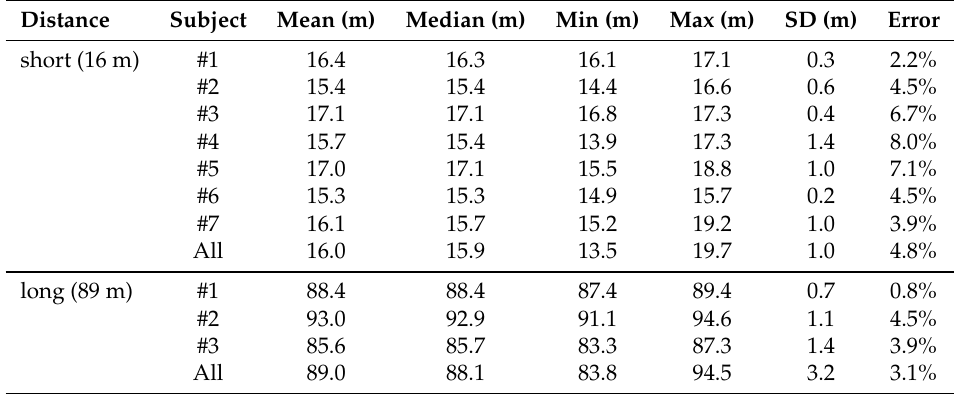
Table 3. Estimated values using the proposed method.